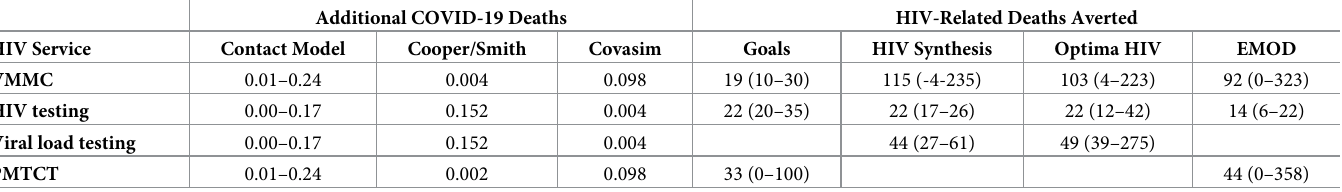
Table 3. COVID-19 deaths among health care workers, clients and family members due to transmission during access to HIV services and HIV-related deaths that could be averted by these services per 10,000 clients.